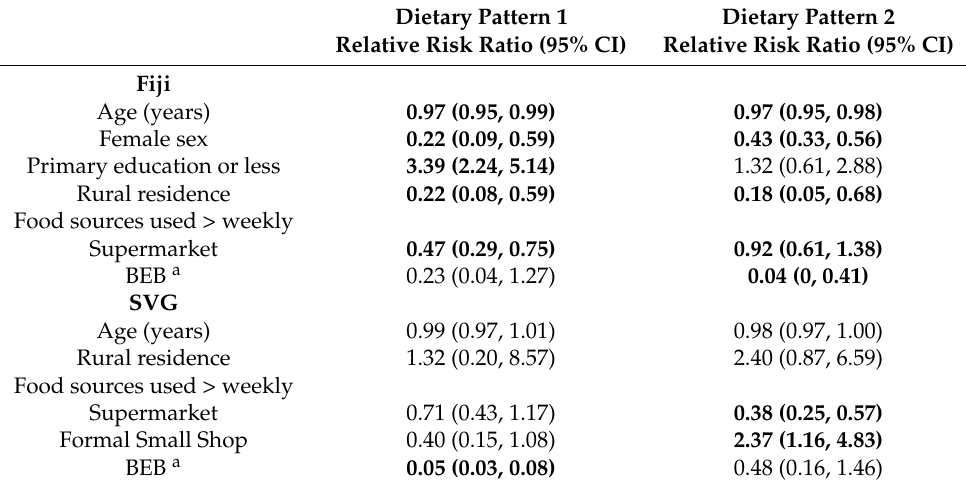
Table 4. Final results from exploratory multinominal regression, with dietary pattern as the dependent variable and food insecurity as the independent